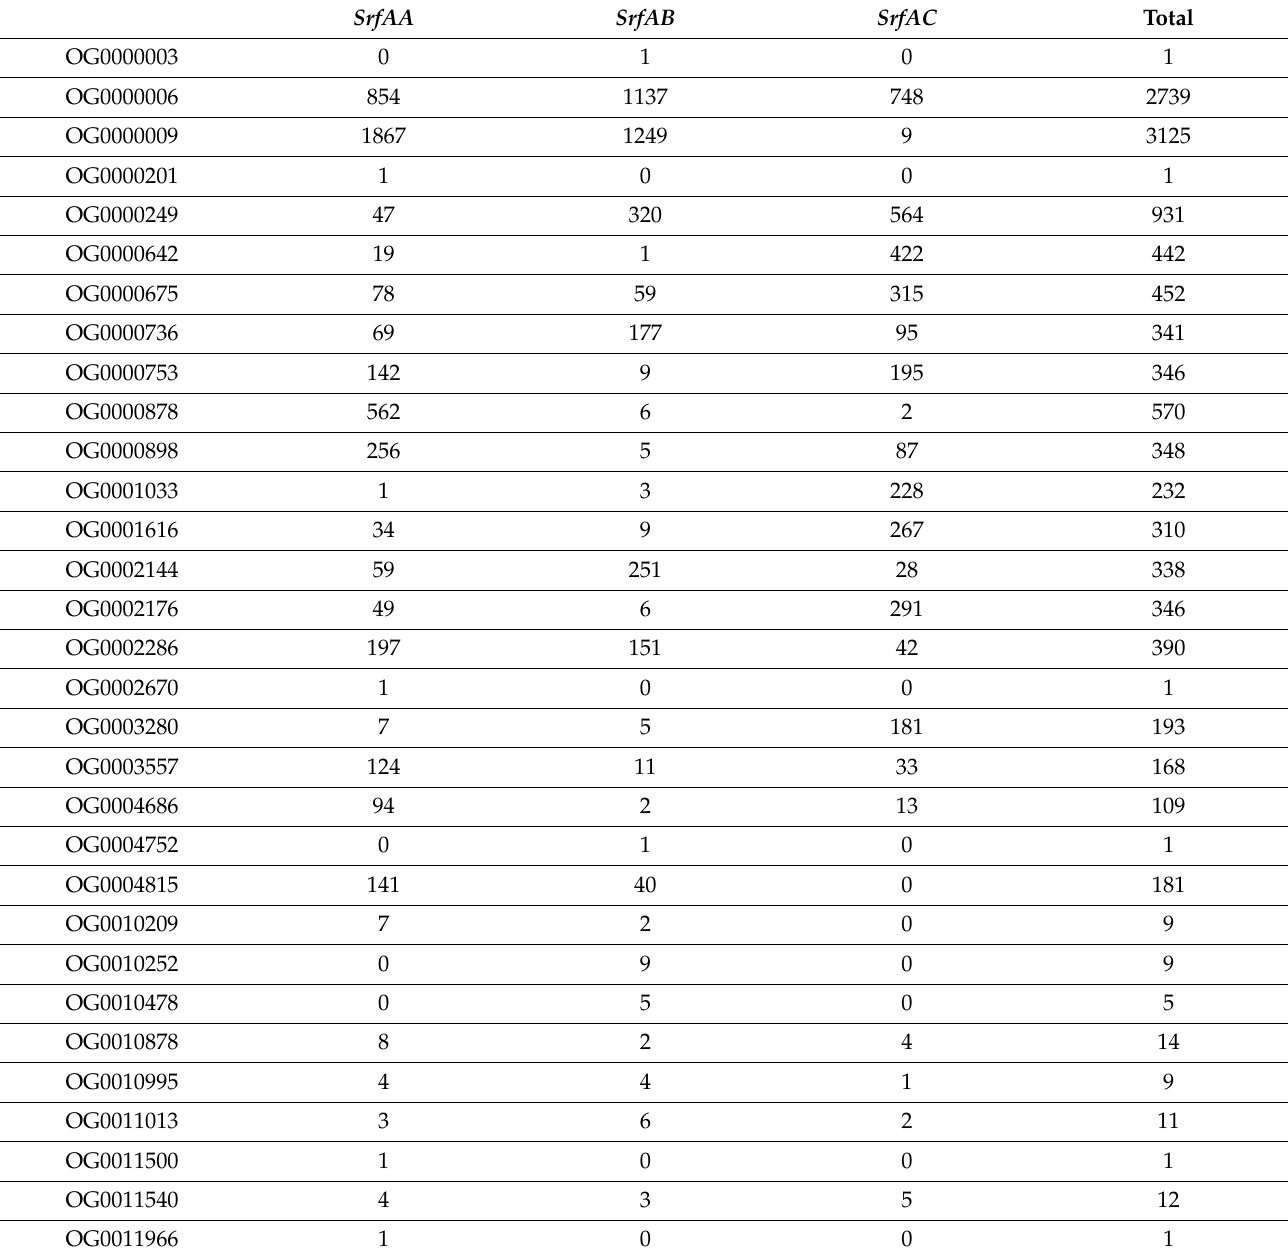
Table 1. The number of SrfAA , SrfAB and SrfAC genes in 66 orthogroups. SrfAA SrfAB SrfAC Total 0